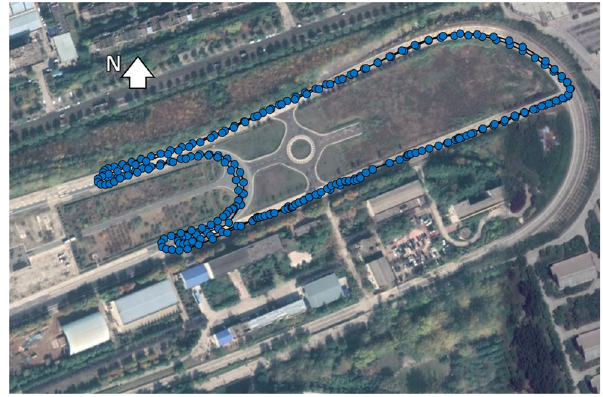
Channel 7 : Accelerometer (ACC) for vehicle braking deceleration rate; and Channel 8: Electroencephalography (EEG) for brain